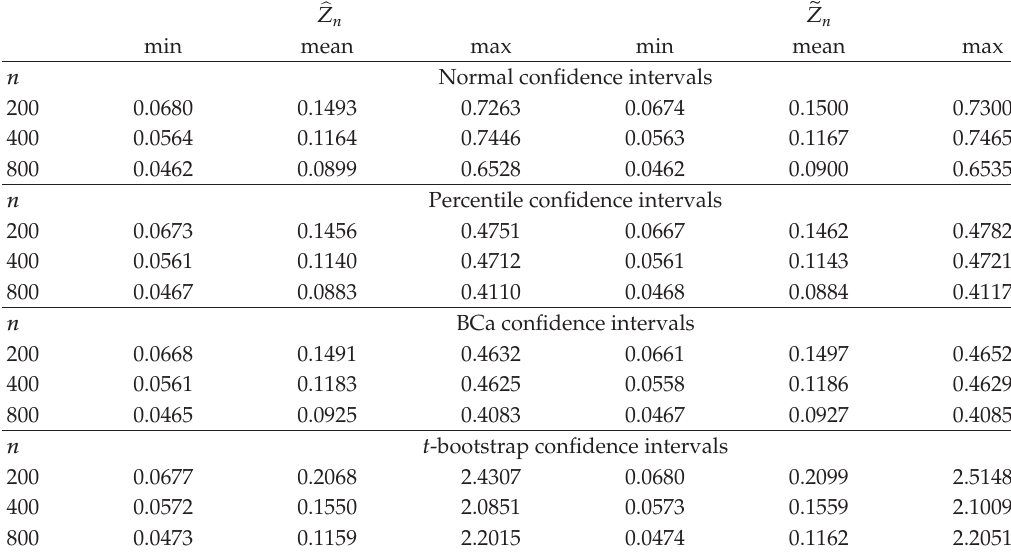
Table 2: Size of the 95% asymptotic confidence intervals from the Pareto parent distribution with x 0 (cid:7) 1 and θ (cid:7) 2 . 06 (cid:3) Z F (cid:7) 0 . 6 (cid:4)